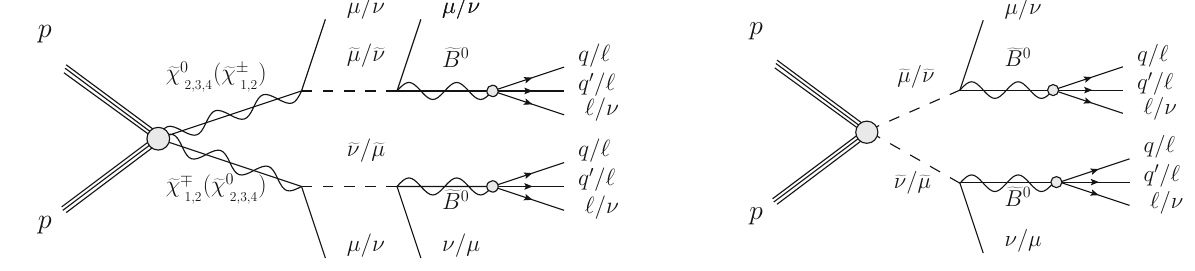
Fig. 4 Production of a chargino pair, chargino-neutralino or a neu- tralino pair, each decaying to a LH muon-sneutrino or smuon, which in